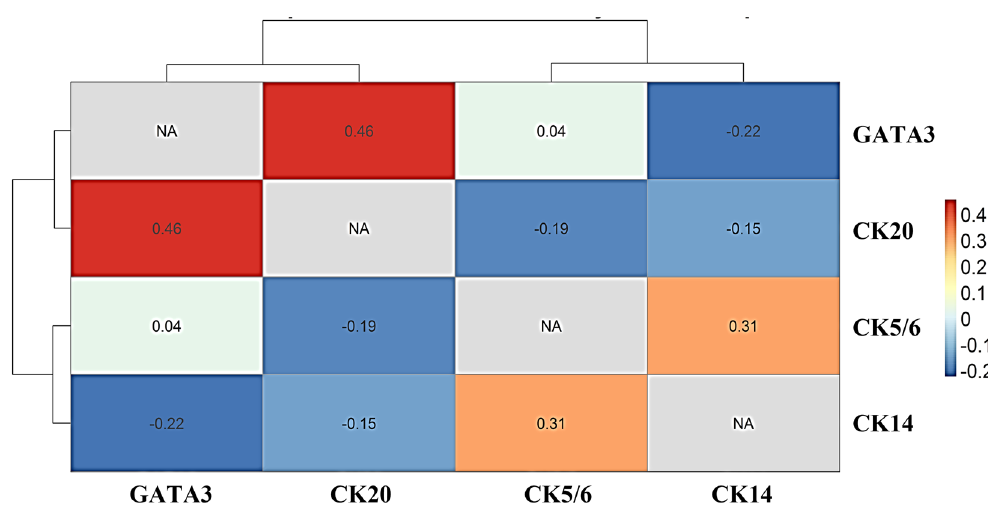
Figure 3. Correlation heatmap of GATA3, CK20 (basal-like markers), CK5/6, and CK14 (luminal-like markers) expression by